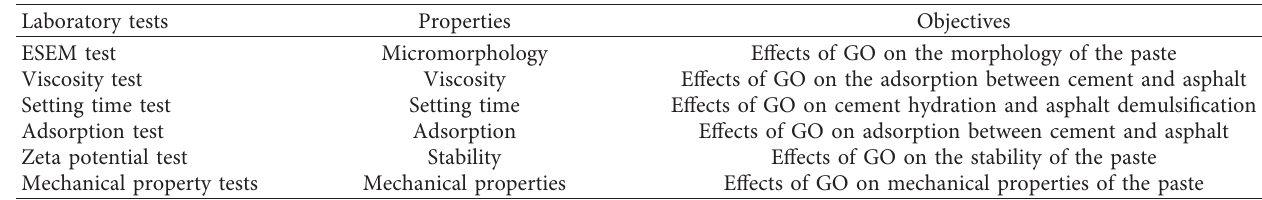
Table 6: The laboratory tests of CEAP.